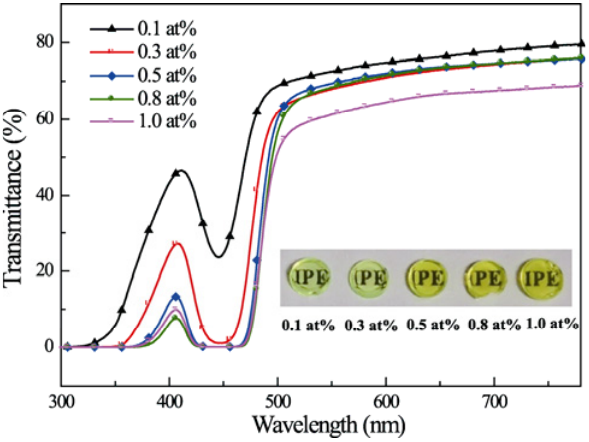
Fig. 5 Transmittance spectra of LuAG–Al 2 O 3 nanoceramics (72 mol% Al 2 O 3 ) doped with different Ce concentrations (1100 ℃ , 2 h). The inset is their